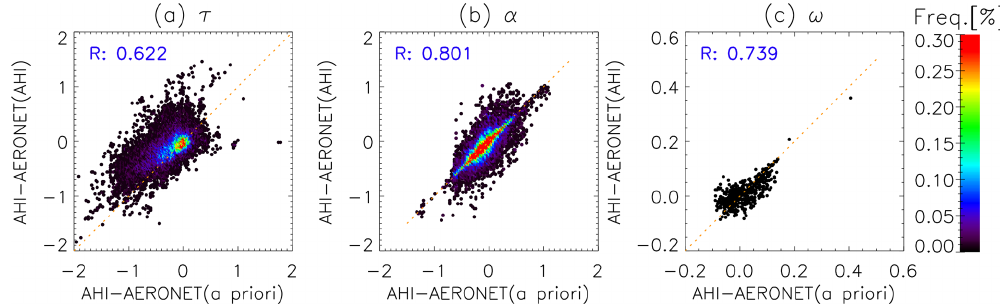
Figure 11. Frequency distribution of the difference between τ (a) , α (b) , and ω (c) retrieved from AHI and those from AERONET, as a function of the difference between τ (a) , α (b) , and ω (c) of an a priori estimate and AERONET. R shows the correlation.